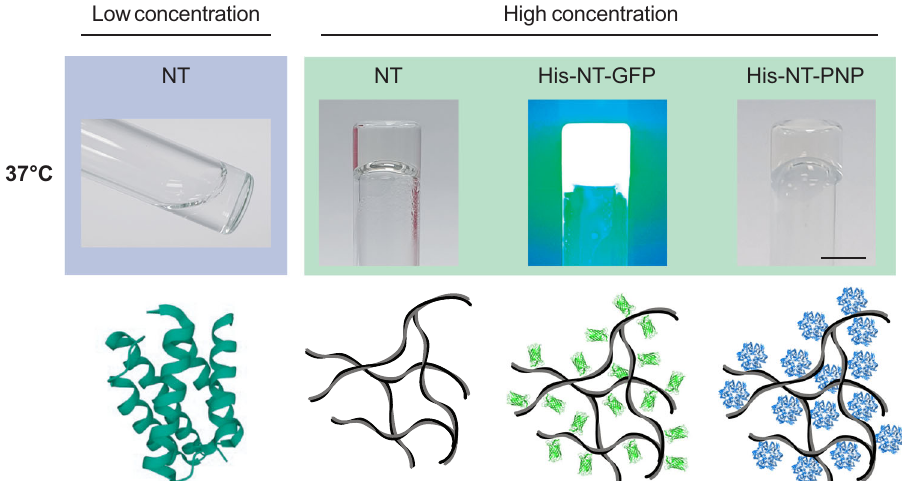
Fig. 8 | Overview of NT gelation. NT is soluble, α -helical and stable at low con- centrations ( μ M) and at 37°C. At the same temperature but at increased con- centrations (>10mg/mL), NT forms gels composed of amyloid-like fi brils. Also NT fusion proteins form fi brillar gels with intact function of the fusion moiety, which